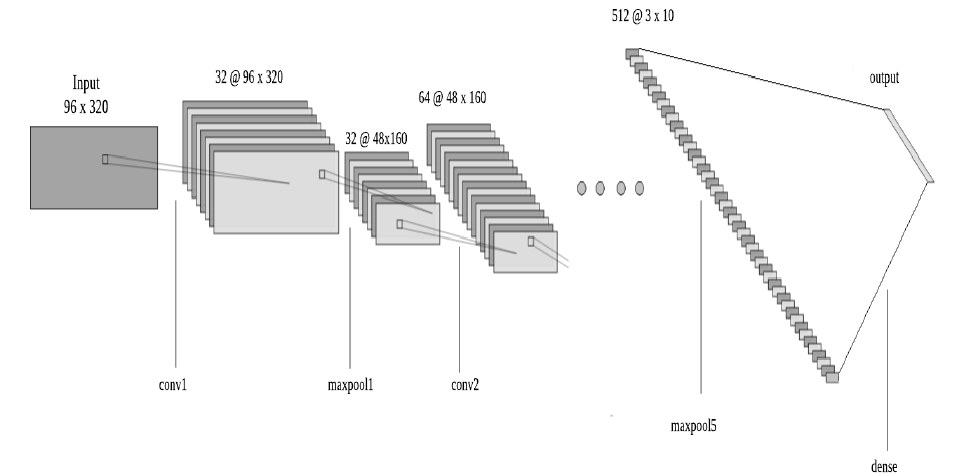
Figure 5. Architecture of proposed